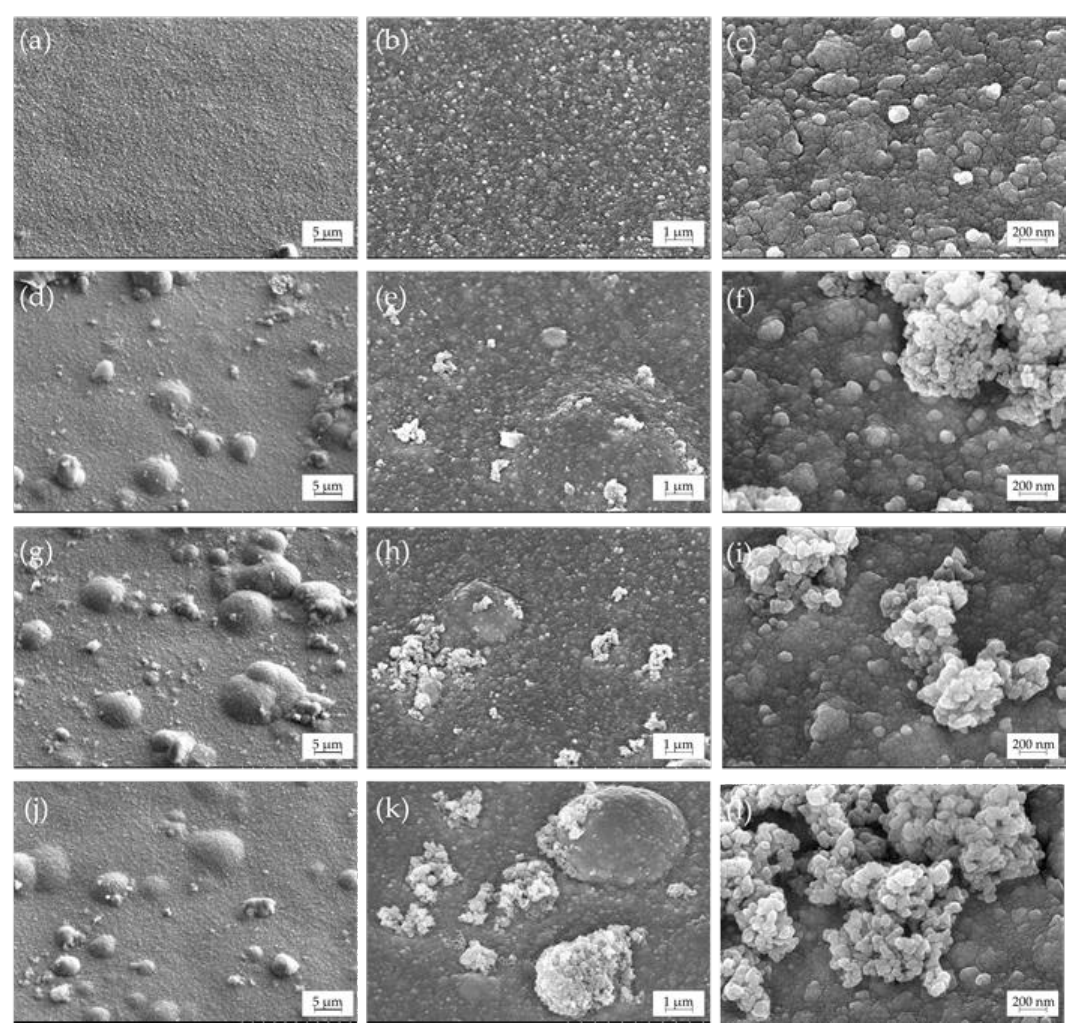
Figure 4. SEM images of Cu–Sn ( a – c ) and Cu–Sn–TiO 2 coatings Ti-1 ( d – f ), Ti-5 ( g – i ), and Ti-10 ( j – l ) deposited at the cathodic potential of −0 .05 V.